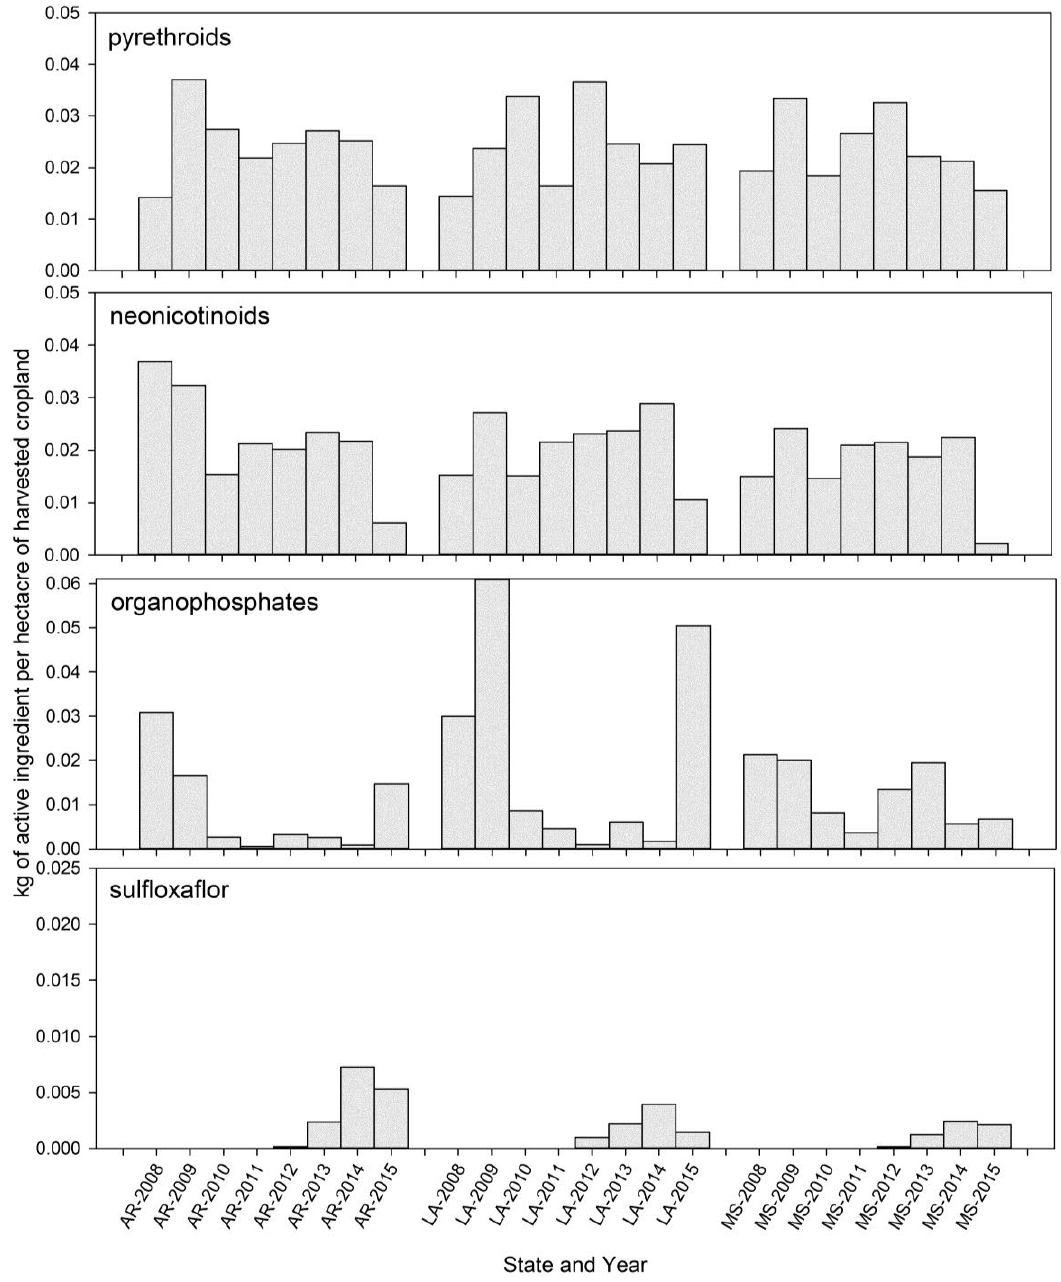
Figure 2. Estimated kg of organophosphate, pyrethroid, neonicotinoid, and sulfoxaflor insecticides applied to cropland in Arkansas (AR), Louisiana (LA), and Mississippi (MS), 2008–2015 [36–38].